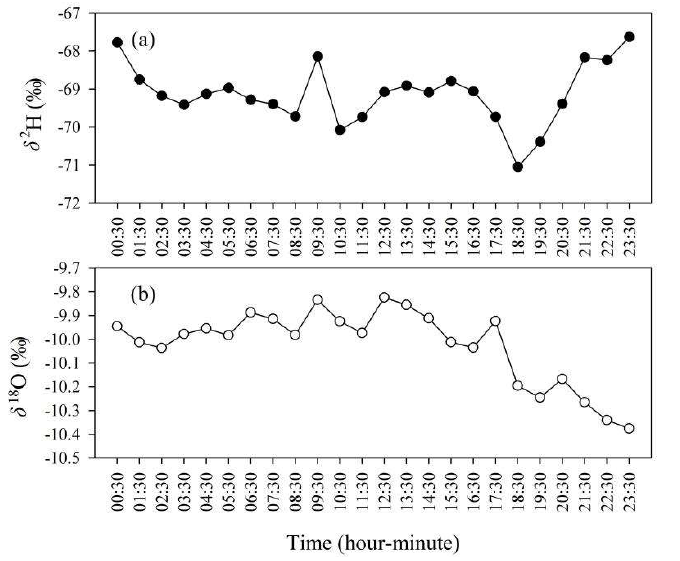
Figure 6. Diurnal variations of stable isotope ratios in tap water at the sampling site of Qiujiawan (T-4) in Lanzhou on March 11, 2018. ( a ) δ 2 H, ( b ) δ 18 O.